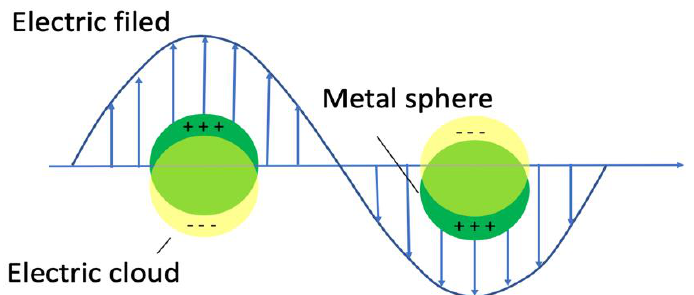
Figure 10. Schematic diagram for a localized surface plasmon excited in a small metallic particle.